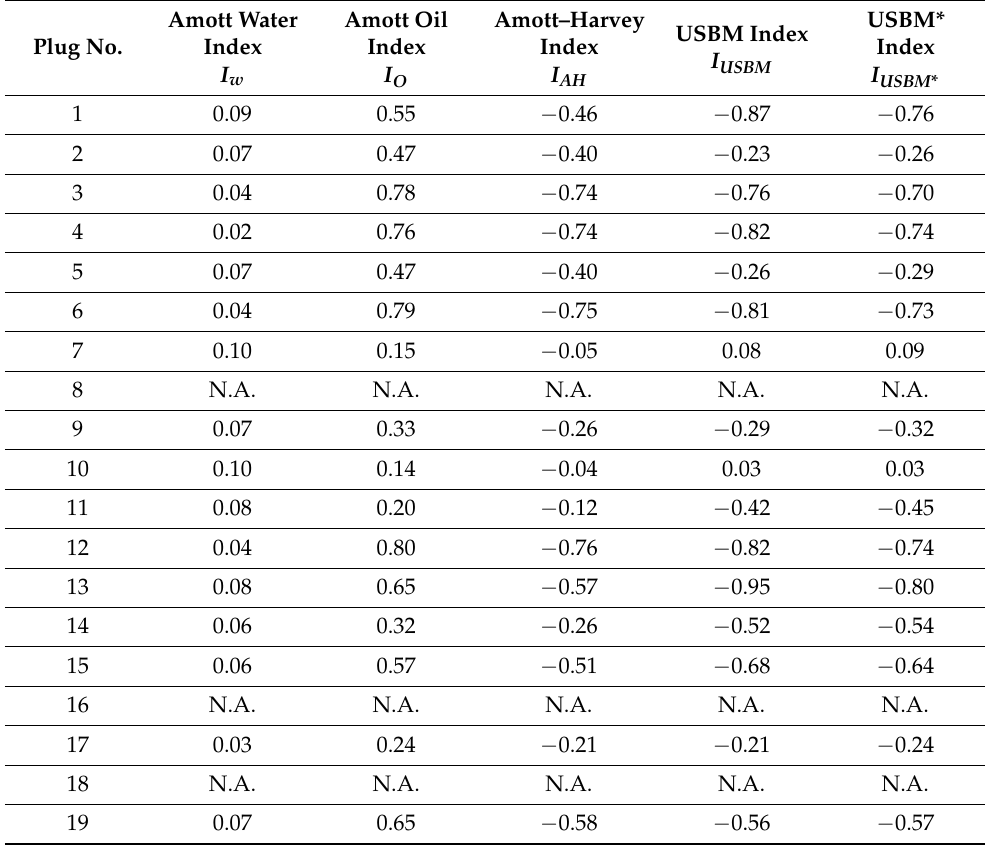
Table 3. The calculated values of the Amott, Amott–Harvey, USBM, and USBM* indices based on fluid displacement through imbibition and/or drainage processes.